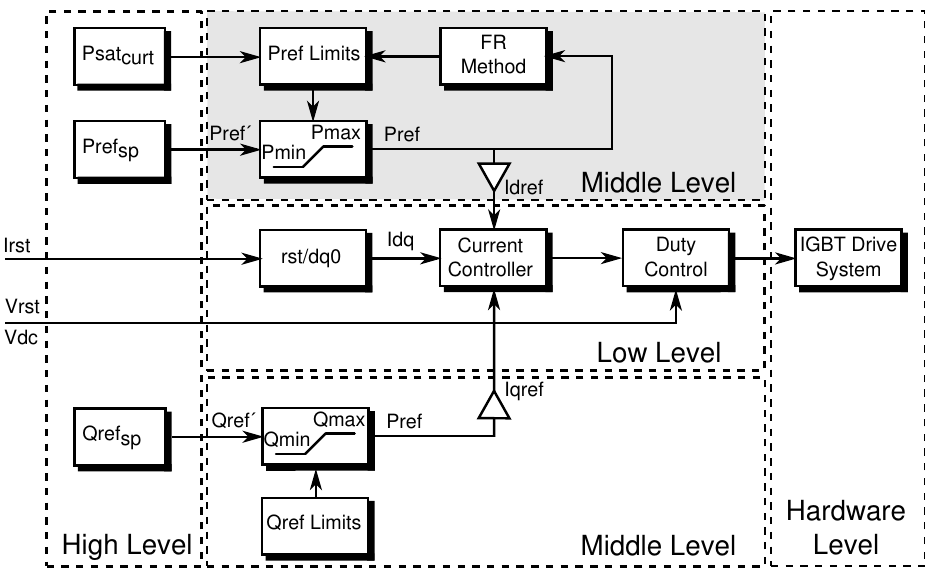
Figure 2. PV converter controller scheme divided into 4 layers: high, middle, low and hardware level. FR method is allocated into the middle layer adjusting the output power reference output.